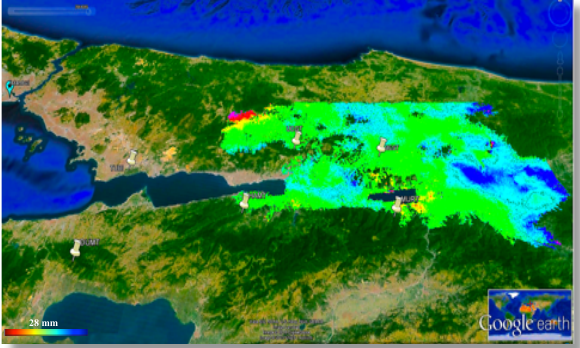
Figure 4: Unwrapped phases derived from ERS-1 and ERS-2 data displayed over a Google Earth image from, data were derived from descending orbits on 21 th and 22 th October. The colour code indicates the phase differences depending on surface changes. Locations of BEST, DUMT HAMT, MURT, TUBI and UCGT stations have been marked on the map.